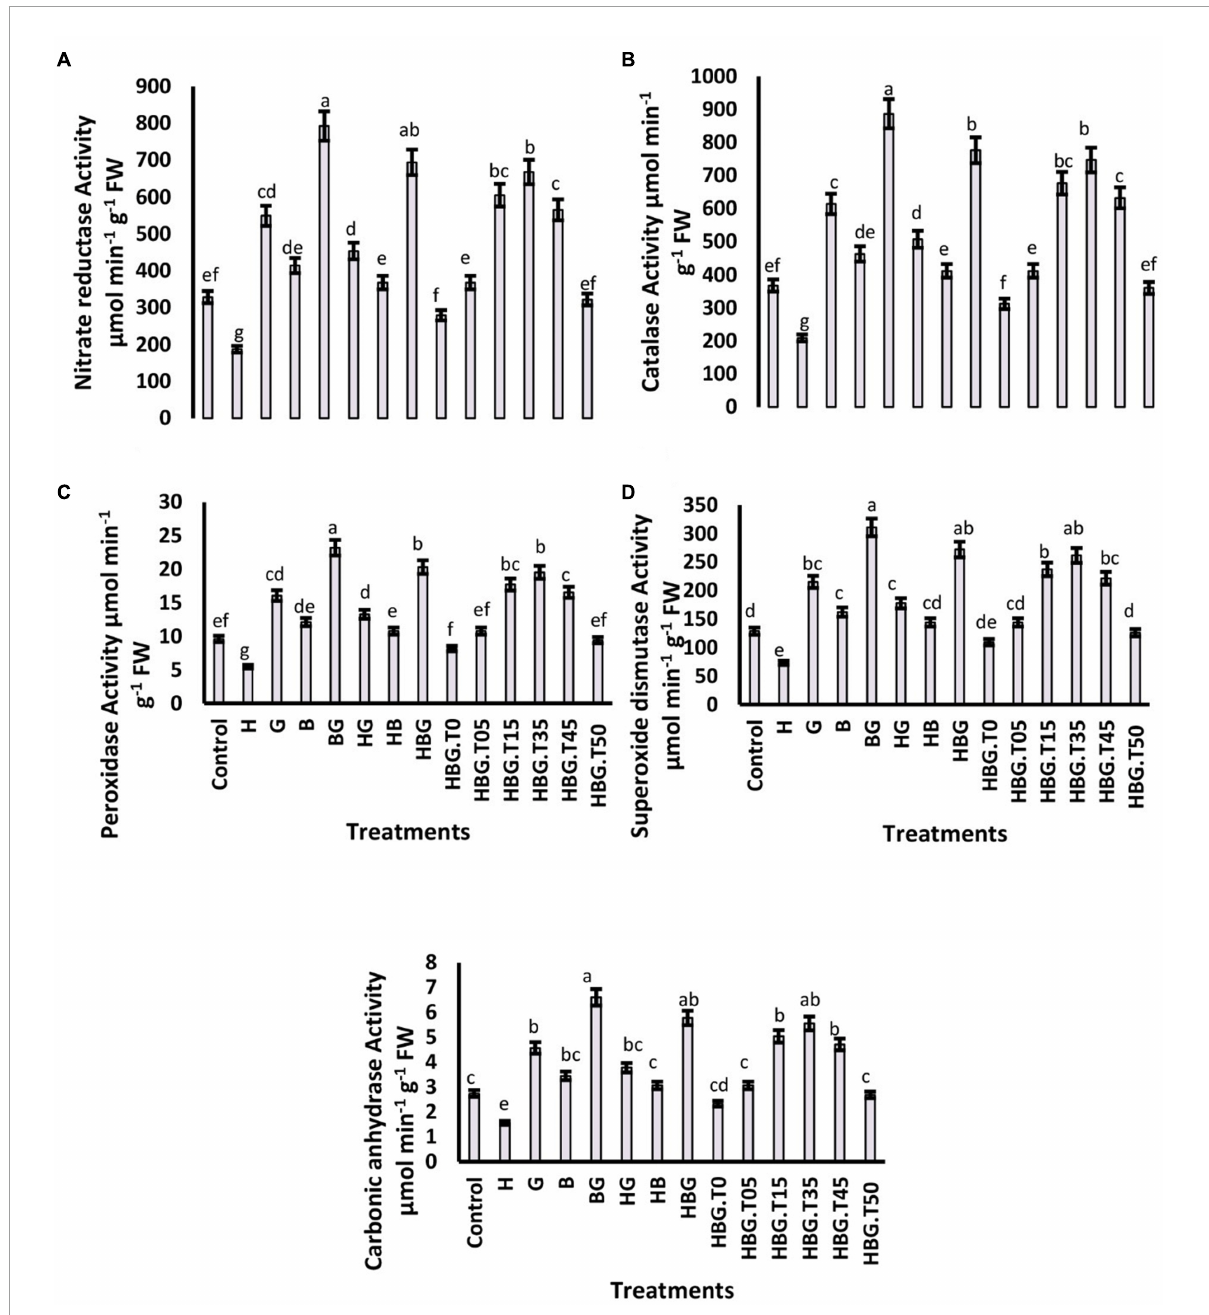
FIGURE2 Effect of GA 3 on antioxidant defense parameters of Brassica alboglabra under HCB toxicity, and temperature stress. Nitrate Reductase Activity (A) , Catalase Activity (B) , Peroxidase Activity (C) , and Superoxide Dismutase Activity (D) . Values demonstrate means ± SD ( n = 5). Different letters indicate a significant difference among the treatments ( P ≤ 0.05). H = HCB; G = GA 3 , B = Bioclay, T0 = 0 ◦ C, T05 = 05 ◦ C, T15 = 15 ◦ C, T35 = 35 ◦ C, T45 = 45 ◦ C, T50 = 50 ◦ C. All treatments without temperature tags got a continuous incubation temperature of 25 ◦